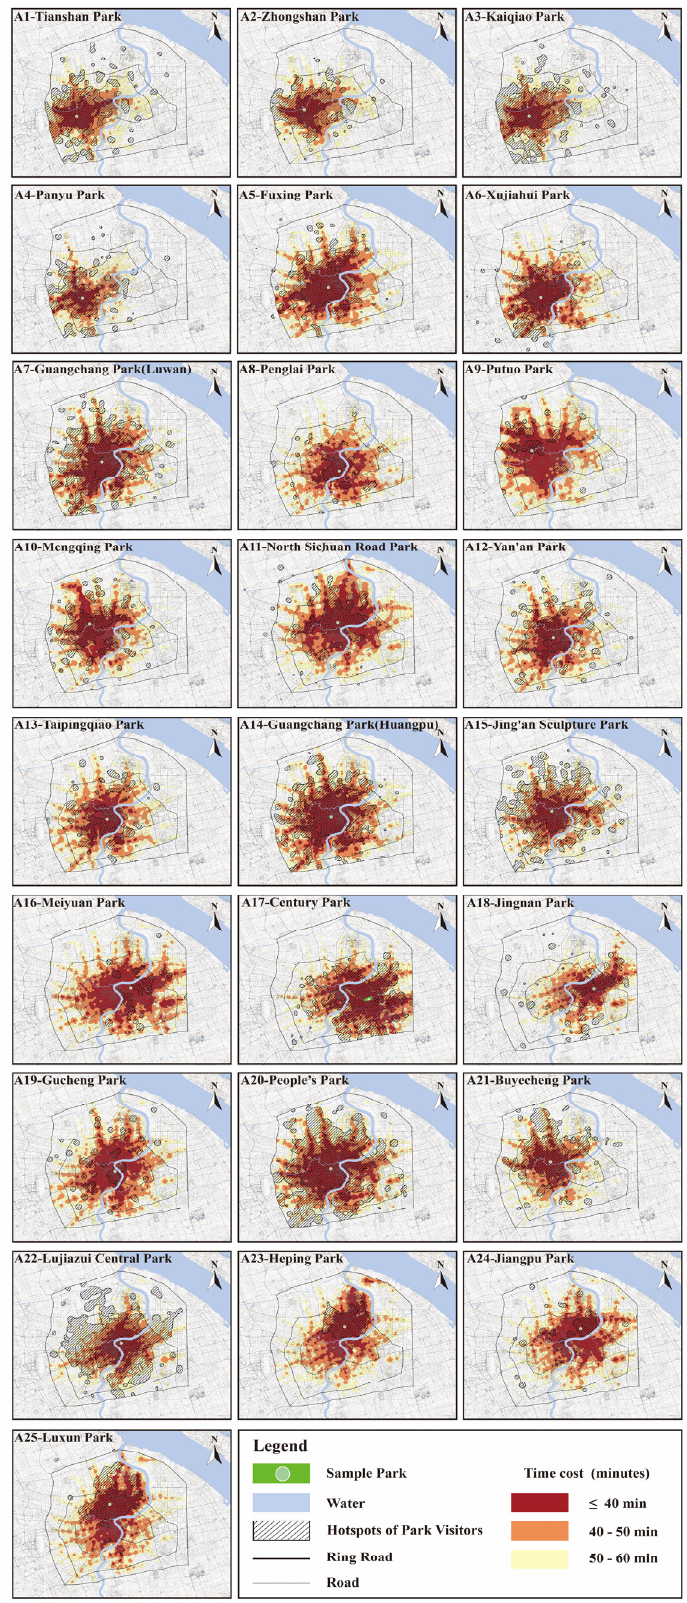
Figure 8. Comparative analysis between park service area and accessibility (Category A).